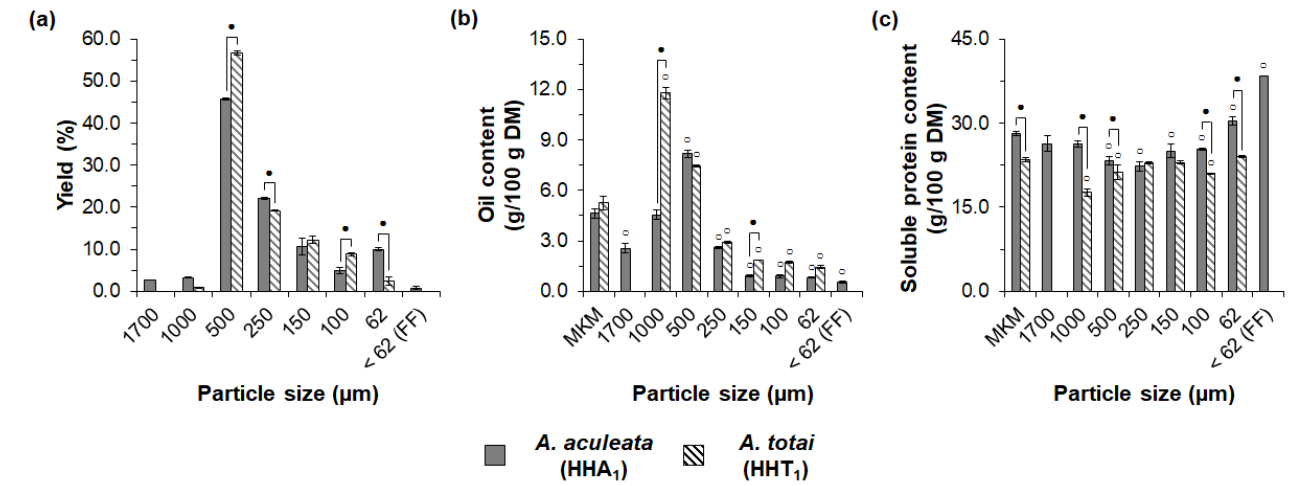
Figure 6. Influence of macauba species on exploratory sieve fractionation of the macauba kernel meals from hydraulic pressing, milling to 1 mm, and solvent extraction with hexane: ( a ) yields, ( b ) oil content, and ( c ) soluble protein content of the sieved fractions. MKM: macauba kernel meal; FF: fine fraction. White circles indicate a significant difference ( p < 0.05) in relation to respective MKMs. Dark circles indicate a significant difference ( p < 0.05) between fractions of the same particle sizes and different macauba species.